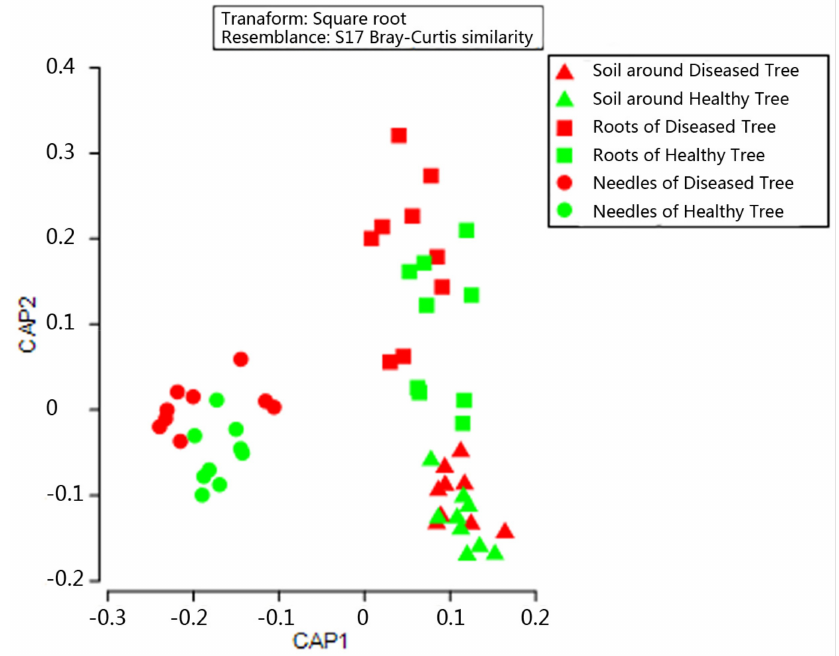
Figure 8. Canonical correspondence analysis (CCA) showing a fungal functional structure in soil, roots, and needles around and of healthy and diseased